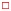
Changes in diffusion properties in the corpus callosum + periventricular white matter (CC+PVWM), ventral internal capsule and external capsule during hydrocephalus development.Diffusion properties in hydrocephalic rats (□) in the CC+PVWM (a) a higher mean diffusivity and (b) lower fractional anisotropy than for controls (□) from day three. In the ventral internal capsule, (c) the mean diffusivity was lower from day seven and (d) the fractional anisotropy was higher than for controls (□) from day three. P values for significance of the interaction between groups in the RM two-way ANOVA tests and significant Sidak’s comparisons are reported for each graph.